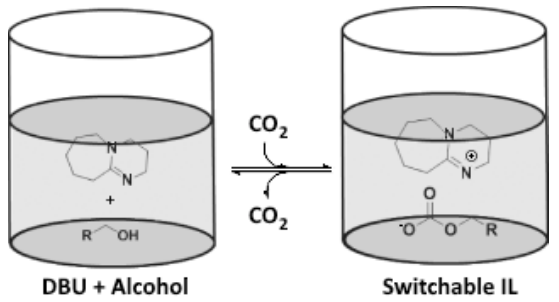
Figure 16. Illustration of the concept and mechanism of switchable ILs; reprinted with permission from [226], Copyright (2013) Society of Chemical Industry.